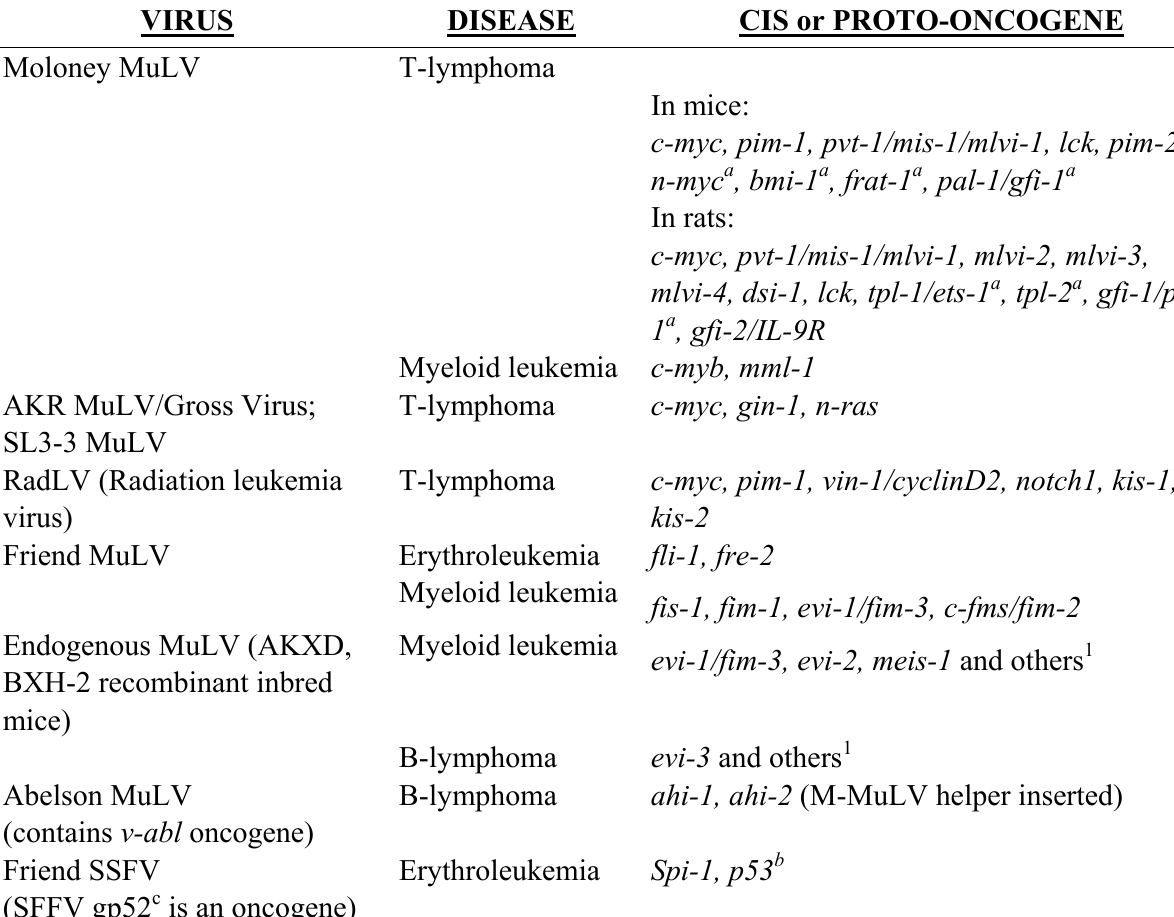
Table 1. Common insertion sites (CIS) or activated proto-oncogenes in MuLV-induced tumors 1